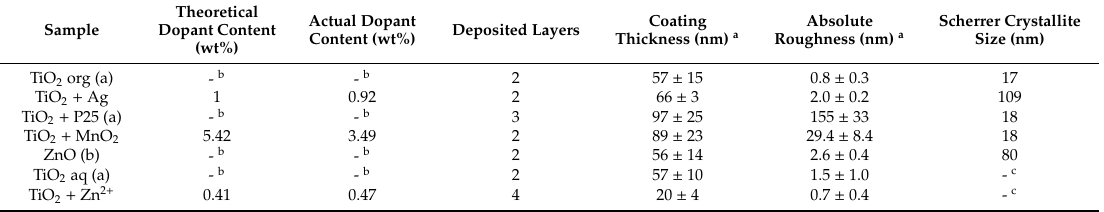
Coating Absolute Scherrer Crystallite Thickness (nm) a Roughness (nm) a Size